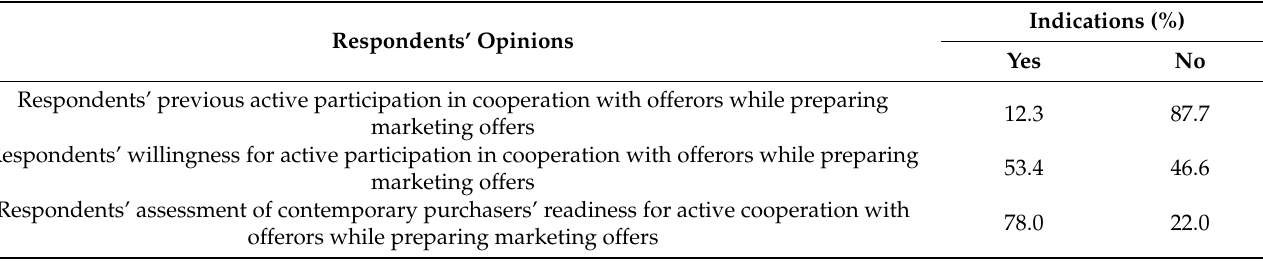
Table 4. Respondents’ previous participation in cooperation with offerors, respondents’ openness to such cooperation, and the assessment of contemporary final purchasers’ readiness for cooperation (%).